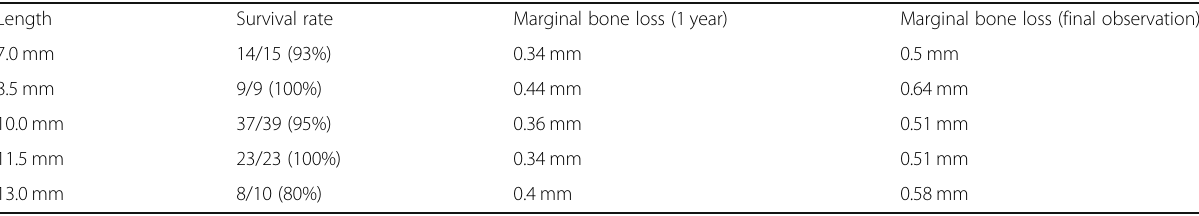
Table 7 Survival rate and marginal bone loss according to fixture length